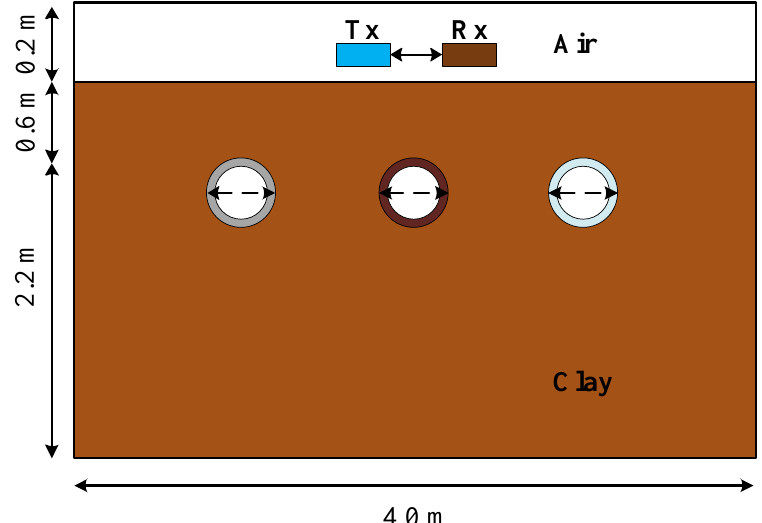
Figure 13. Underground multi-pipe model with different pipe materials.